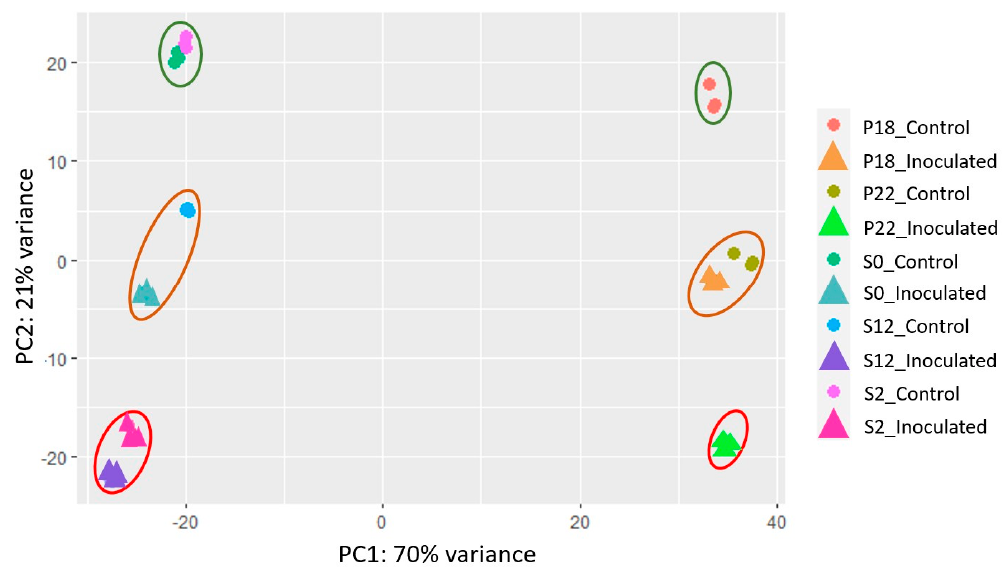
Figure 6. Principal component analysis (PCA) of whole-genome expression for Pallas NILs containing mlo-5 (P22) and Mlo (P18) and Baudin NILs containing mlo-11 (S12), mlo-11 ( cnv2 ) (S2), and Mlo (S0) in control and Bgh inoculated samples. PC1 represents the main variance (72%) between Baudin and Pallas genotypes, while PC2 shows the variation (20%) between Mlo or mlo alleles and treatments (control versus Bgh inoculated).